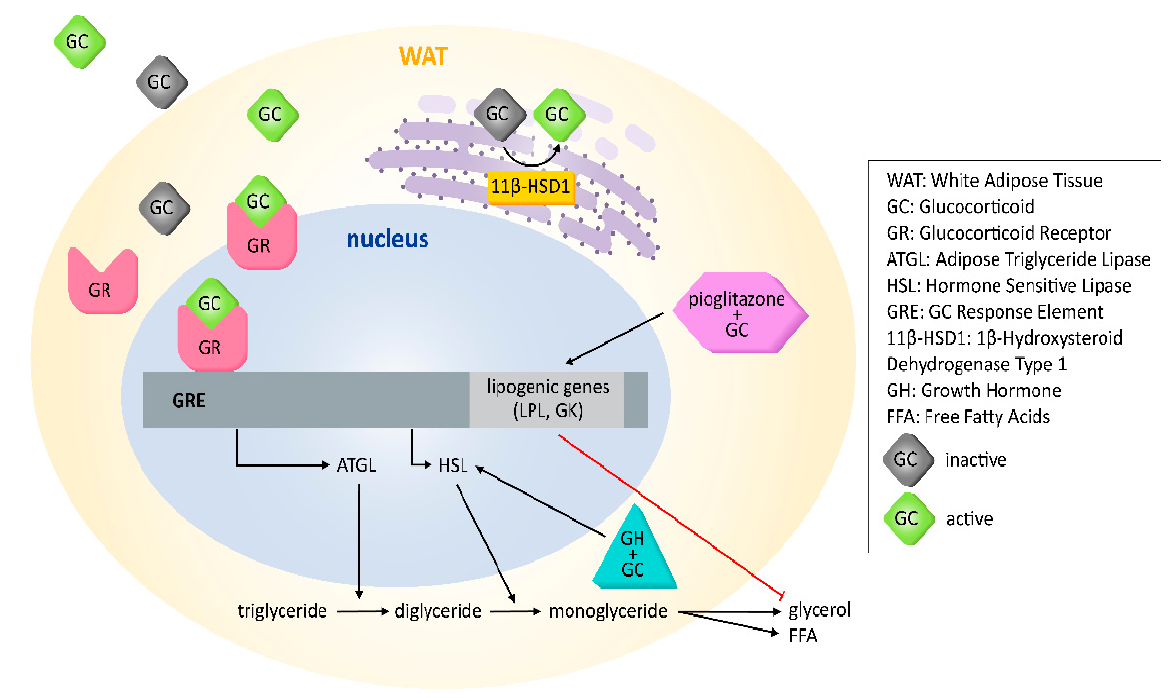
Figure 1. Genomic effects of GCs on lipolysis in WAT. The genomic effects occur through the binding of GC to the GR and the movement of GC-GR to the nucleus, where they can regulate the transcription of genes related to lipid metabolism, including lipolytic enzymes ATGL and HSL. Other regulators of lipid metabolism, such as pioglitazone (peroxisome proliferator-activated receptor gamma ligand) and growth hormone (GH), have counterbalancing effects to glycerol release that alter the way GCs induce lipolysis.